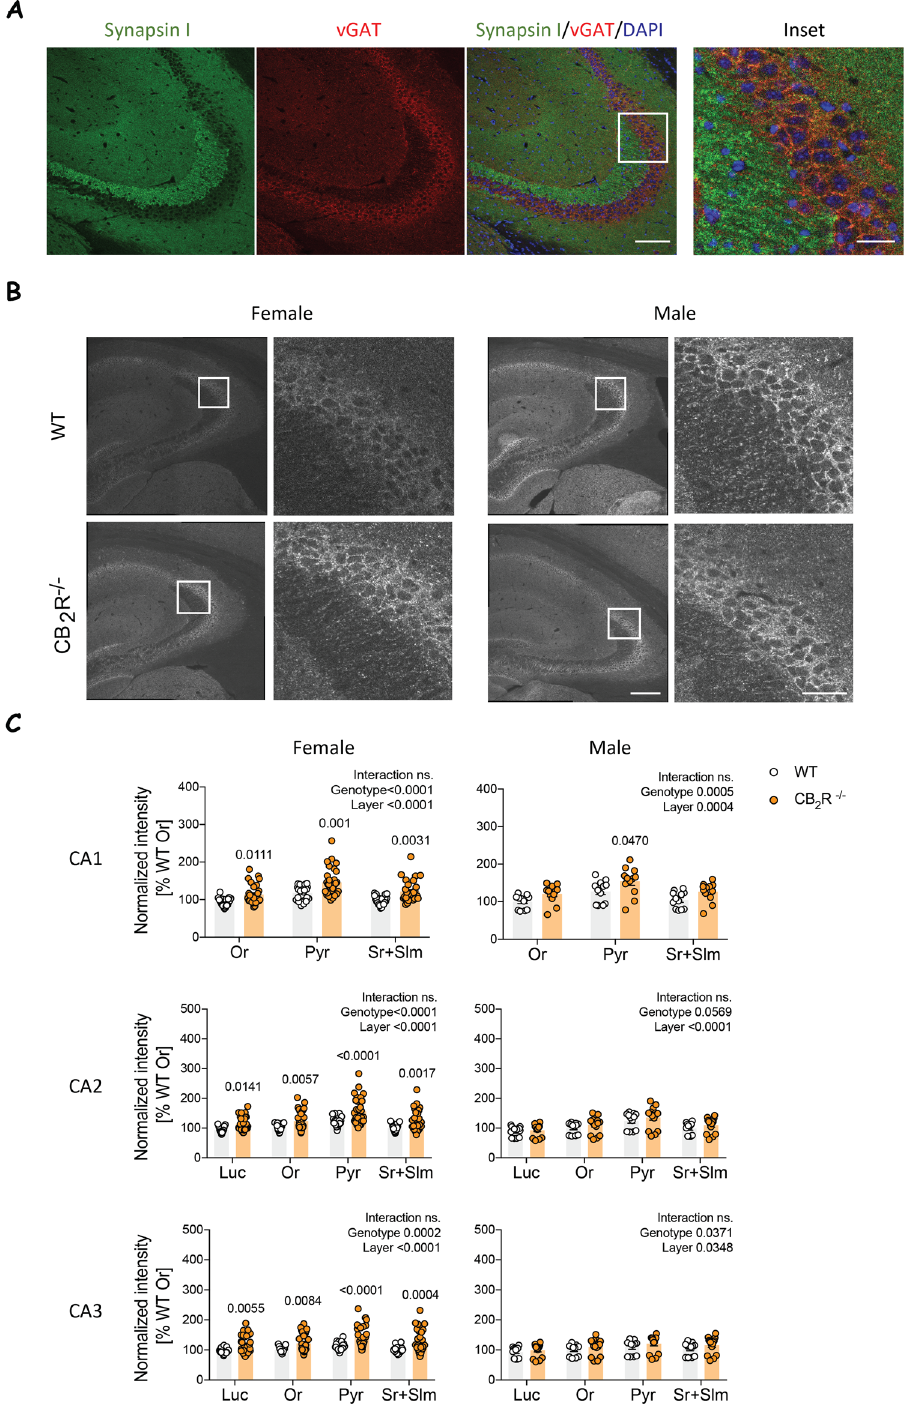
Figure 4. vGAT levels are increased in female CB 2 R −/− mice. ( A ) Example images show synapsin-I (green), vGAT (red) and DAPI (blue). Scale bar: 100 µm, 25 µm (inset). ( B ) Example images of vGAT immunoreactivity in male and female from WT and CB 2 R −/− mice. The white box within the left panel indicates the section that is displayed in higher magnification on the right. Scale bar: 200 µm, 25 µm (inset). ( C ) Quantification of vGAT mean grey value within each hippocampal layer normalized to the result from stratum oriens (Or). Or stratum oriens, Luc stratum lucidum, Pyr stratum pyramidale, Sr + Slm stratum radiatum and stratum lacunosum-moleculare. White circle—WT; orange circle—CB 2 R −/− mice. Each datapoint represents one image. Left panel—female mice (WT: n = 30 images from N = 9 mice; CB 2 R −/− : n = 31 images from N = 9 mice); right panel—male mice (WT: n = 12 images from N = 3 mice; CB 2 R −/− : n = 16 images from N = 4 mice). Top panel—CA1 region; middle panel—CA2 region; bottom panel—CA3 region. Data is displayed as mean value ± SEM. Data was analyzed by two-way ANOVA followed by Sidak’s multiple comparison test. The exact p-values are indicated on the graph and reported in Supplementary Table